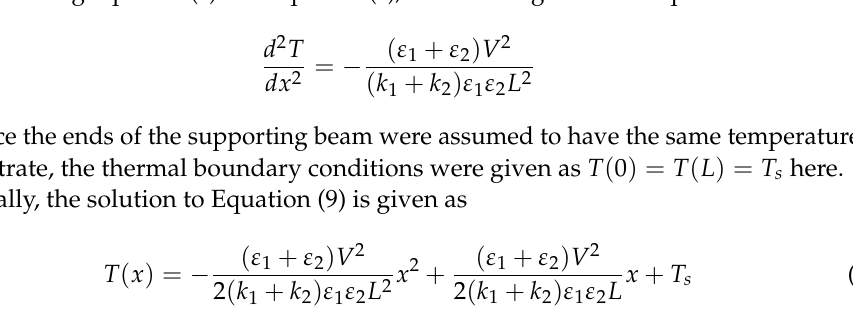
Figure 5. The equivalent U-shaped bilayer beam for the bilayer solar sail of the microrobotic Chip-Sail.